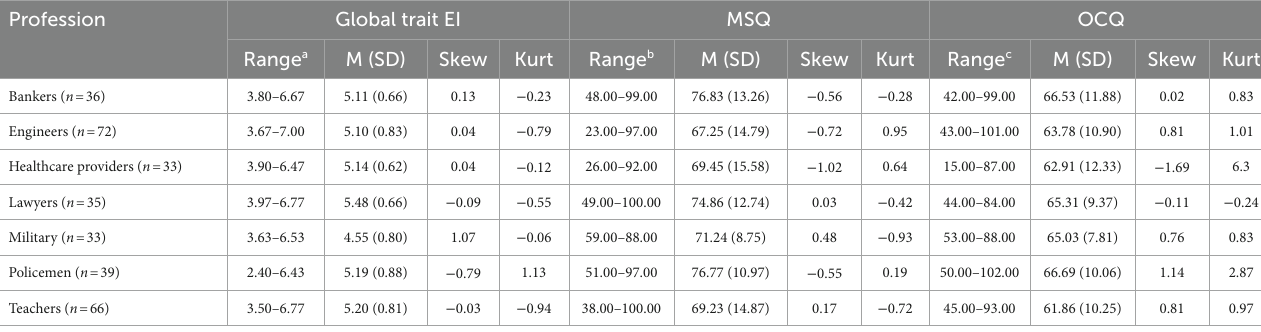
TABLE 2 Descriptive statistics for the key variables in the study across professions.